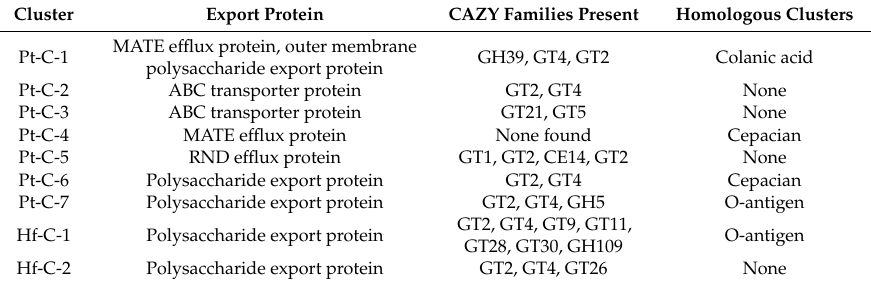
Table 3. Carbohydrate enzyme families and export proteins in biosynthetic gene